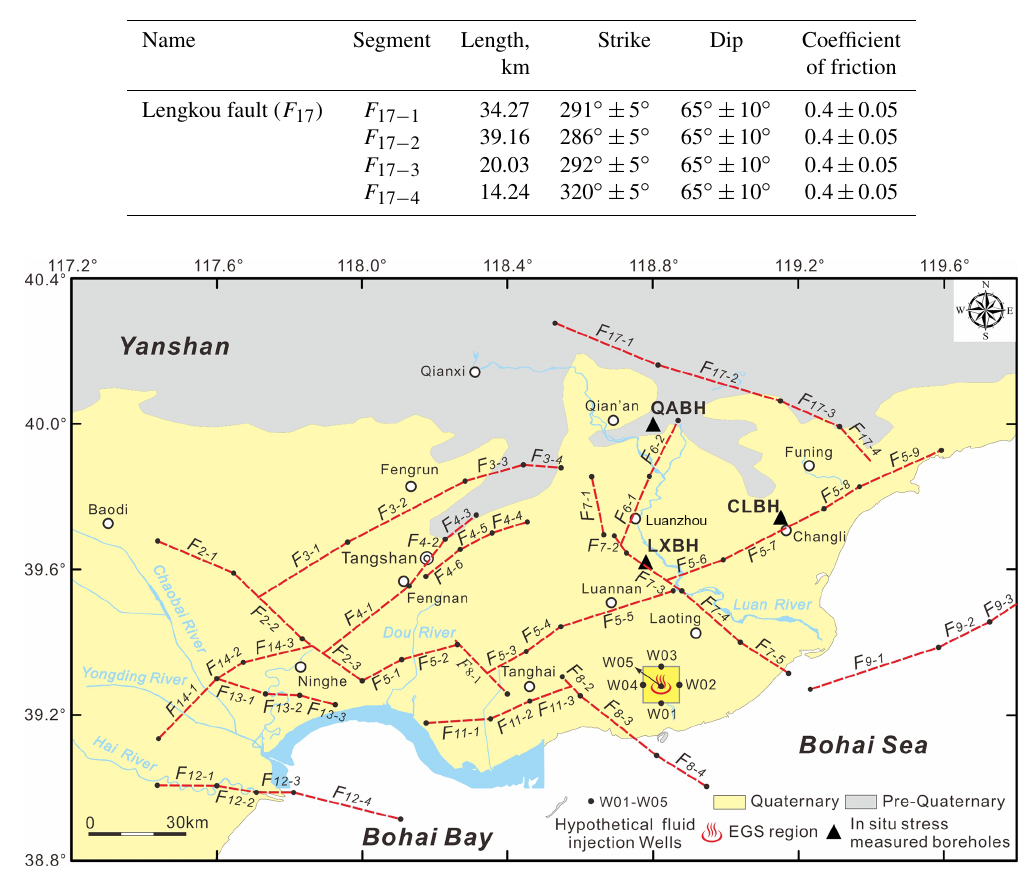
Figure 6. Simplified segmental faults with different strikes in the Tangshan seismic region. There are a total of 53 segments used for calculating the fault slip potential